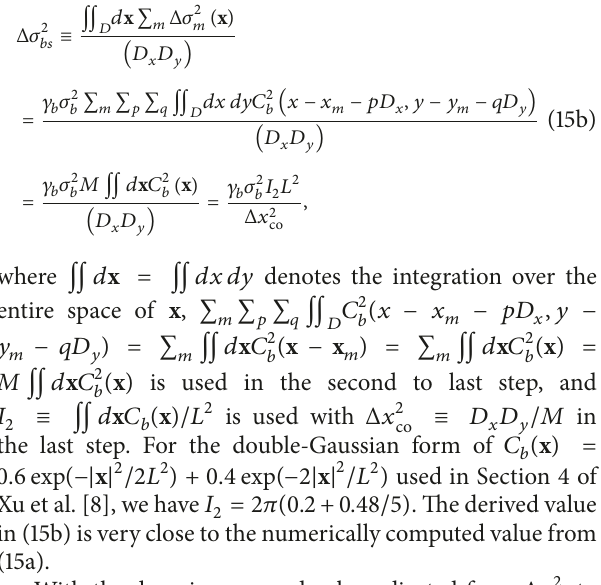
𝐿 in x , where Δ𝑥 (or Δ𝑦 ) is the grid spacing in the 𝑥 (or 𝑦 ) direction and Δ𝑥 = Δ𝑦 is assumed for